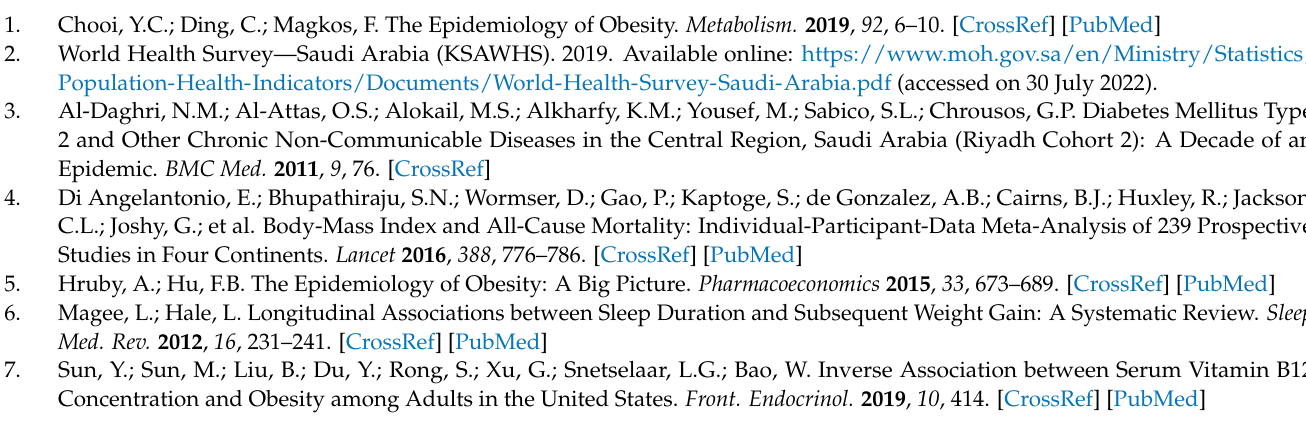
Table S2. Lifestyle Parameters of Participants According to Body Mass Index and Vitamin D status. Table S3. Correlation coefficients between vitamin D intake and gut microbiota among study groups. Figure S1. Comparison of bacterial diversity (Shannon-Wiener index) between the microbiota at the species level of group with obesity and group with normal weight based on BMI and severe vitamin D deficiency (<25 nmol/L). Figure S2. Comparison of bacterial diversity (PERMANOVA Analysis) between the microbiota at the species level of normal weight and participants with obesity based on BMI and severe vitamin D deficiency (<25